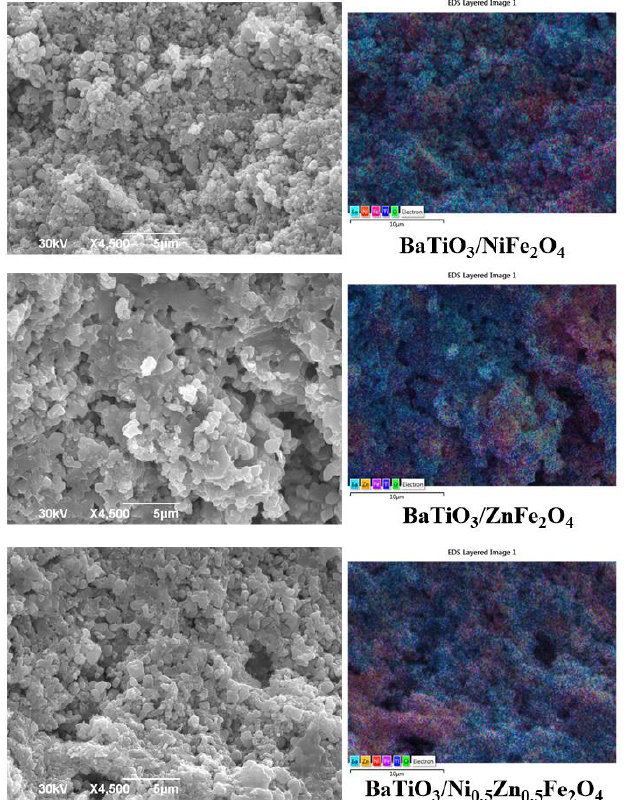
Figure 3. SEM and EDS layered images of BaTiO 3 /NiFe 2 O 4 , BaTiO 3 /ZnFe 2 O 4 , and BaTiO 3 /Ni 0.5 Zn 0.5 Fe 2 O 4 samples sintered at 1150 °C (Ba-cyan; Zn-yellow; Ni-orange; Fe-magenta; Ti-blue; O-green).